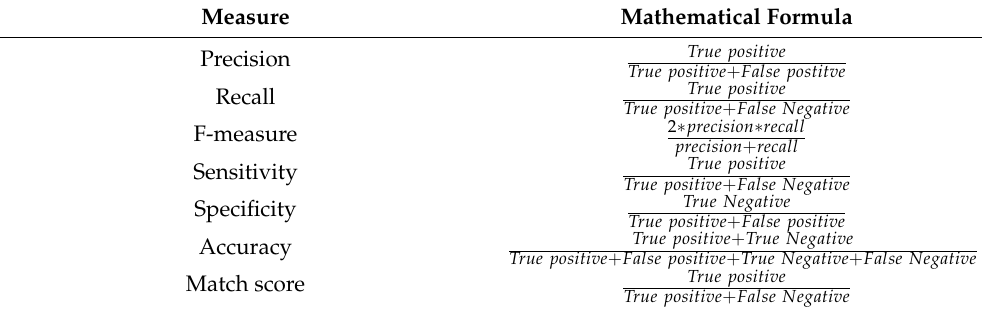
Table 10. Measures used for evaluation.